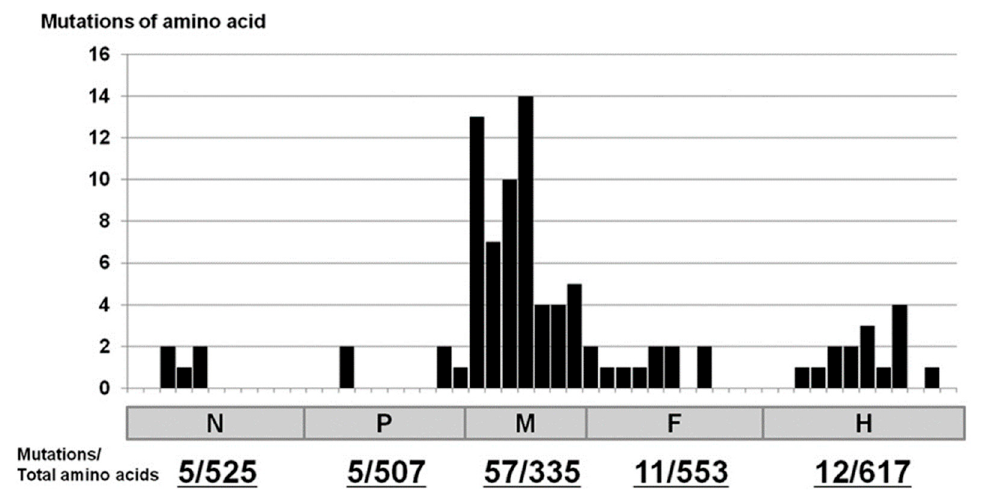
Figure 2. Amino acid mutations in viruses derived from brains of mice with persistent. Measles Virus infection. The genes are listed on the horizontal axis. Each horizontal axis tick represents 50 amino acids. The number of amino acid mutations is presented on the vertical axis. Among the 10 clones, when any 1 clone had an amino acid mutation at a position, it was counted as one mutation. Overlapping mutations at the same position in multiple clones were counted as a single mutation [33].